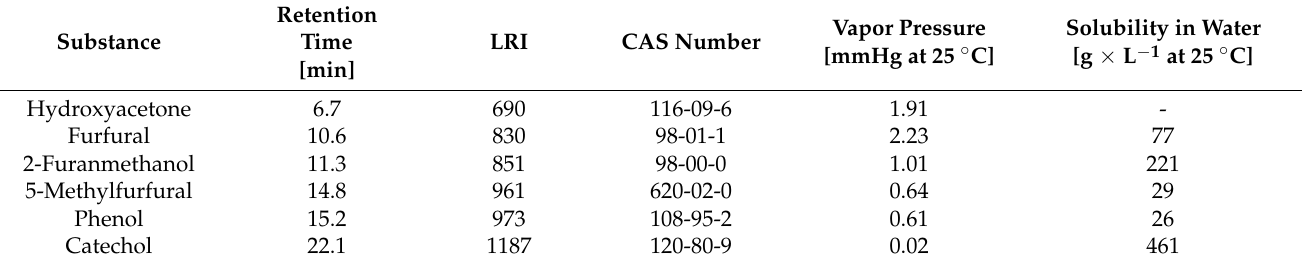
Table 4. Identified substances, their respective retention time and retention index on the HP5 column, as well as their CAS number, vapor pressure and water